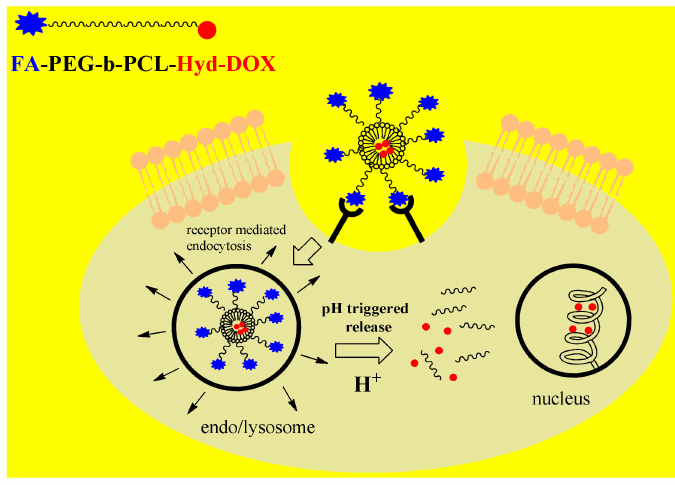
Figure 3. Mechanism of action of pH-responsive polymer nanoparticles(NPs) decorated with targeting ligand folic acid (FA) and with the drug doxorubicin(DOX)bound via a hydrazone bond to diblock copolymerPoly(ethylene glycol)-b-poly( ε